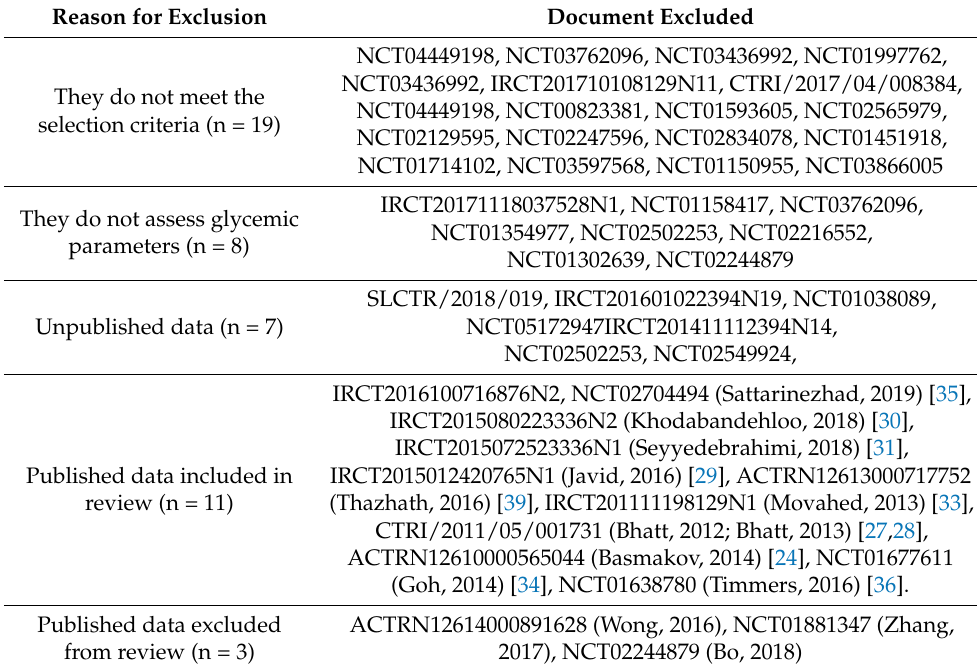
Table A2. Records of clinical trials excluded from the systematic